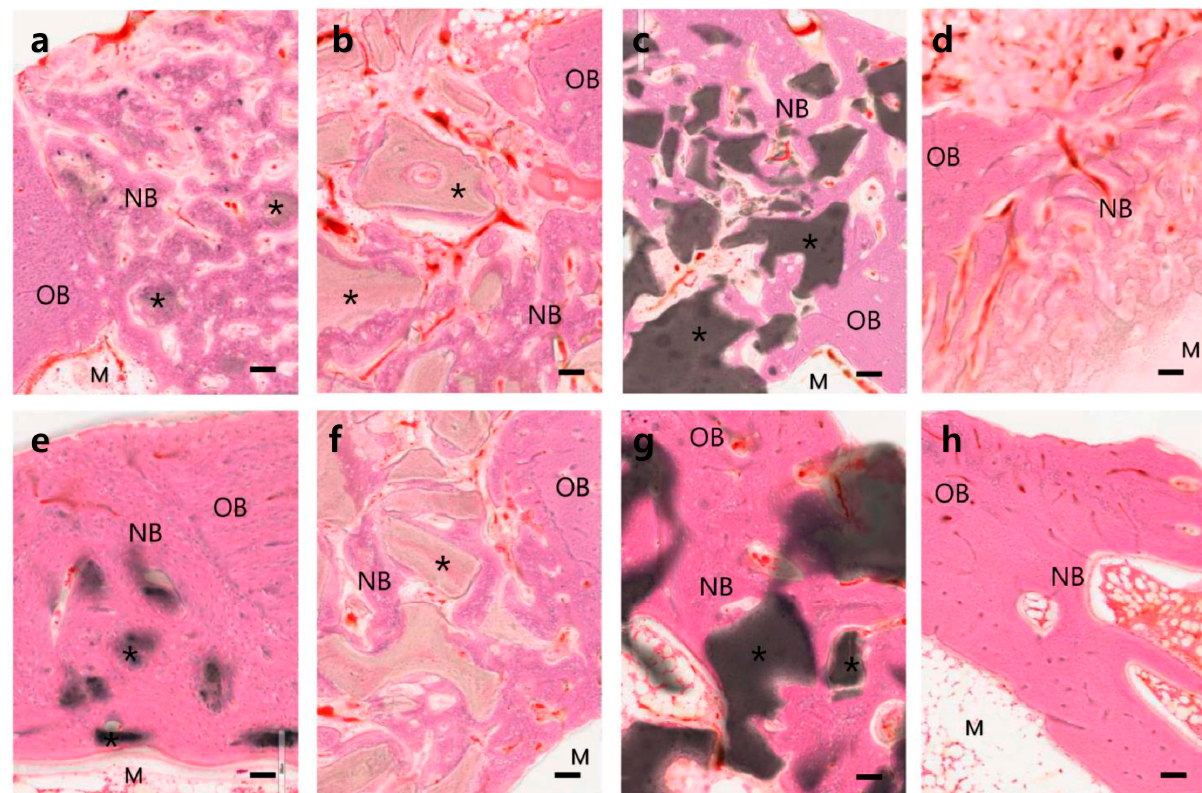
Figure 5. Microphotographs of the tibias at four ( a – d ) and 12 ( e – h ) weeks after implanting of OCP ( a , e ), BHA ( b , f ), BCP ( c , g ), and CON ( d , h ) materials. OB: old bone, NB: new bone, M: marrow, *: implant material. H-E stain was used; bars indicate 100 μ m.